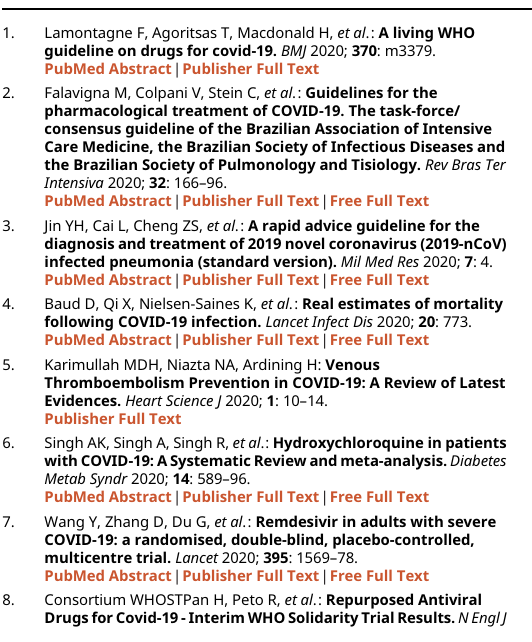
Figshare: PRISMA checklist for ‘ Association between convalescent plasma and the risk of mortality among patients with COVID-19: A meta-analysis ’ , https://doi.org/10.6084/m9.figshare.13490541.v1. 46